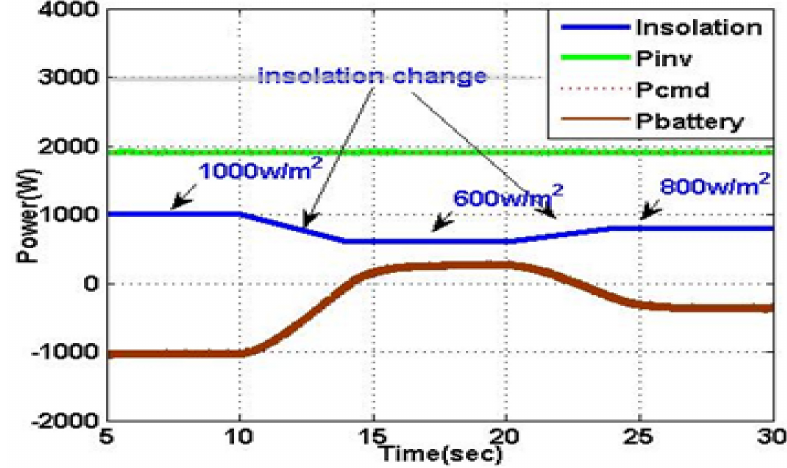
Figure 7. Operation of proposed system with insolation change and constant power output.